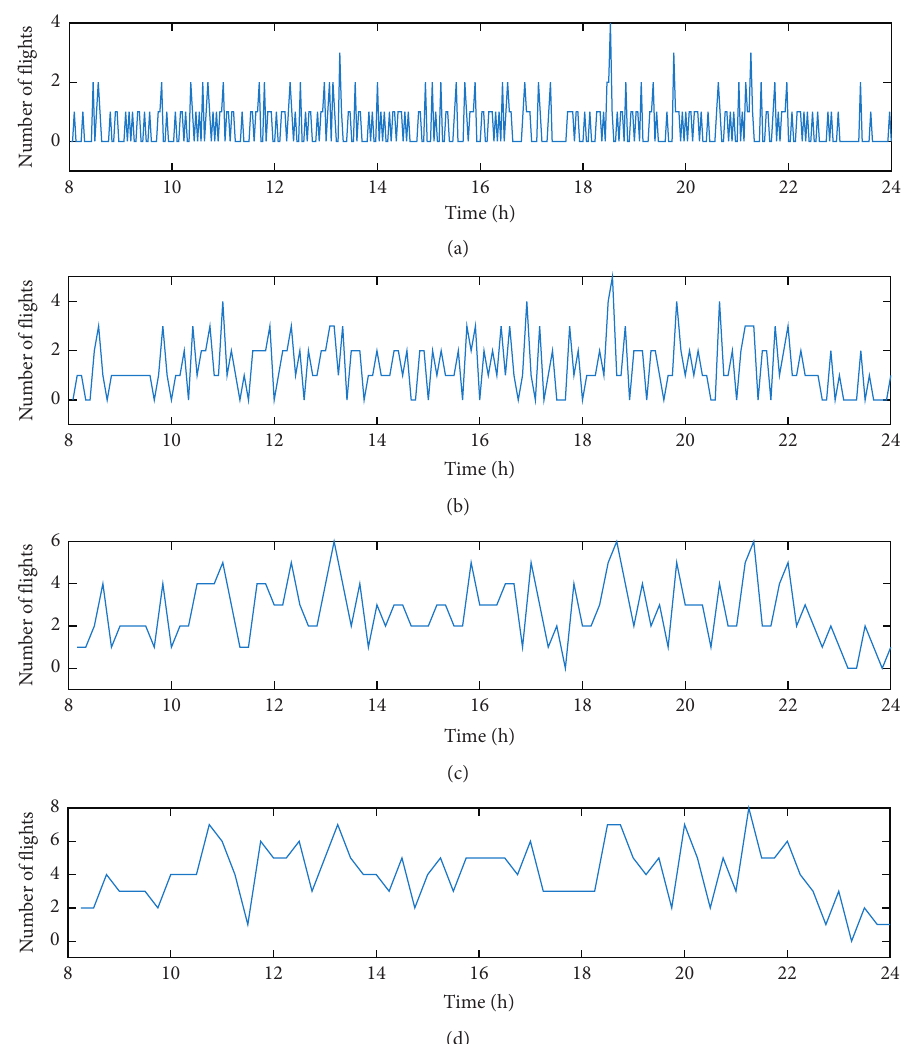
Figure 7: Different time scales of the time series. (a) Δ t � 2min. (b) Δ t � 5min. (c) Δ t � 10min. (d) Δ t �